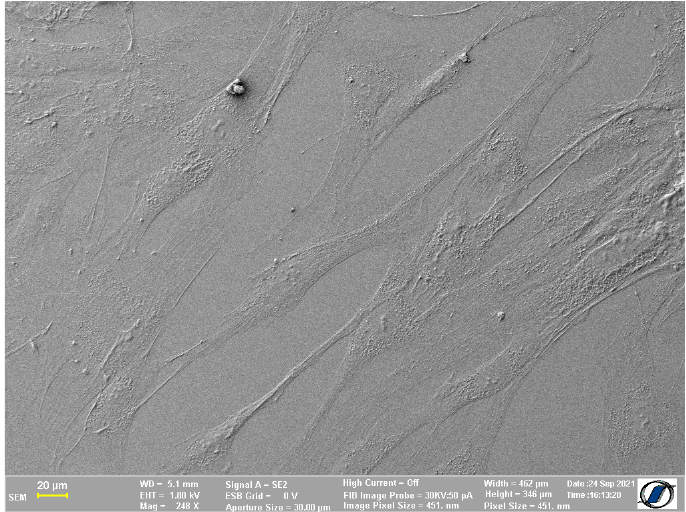
Figure 2. A dipose-derived mesenchymal stem cells—air dried. Figure 2. Adipose-derived mesenchymal stem cells—air